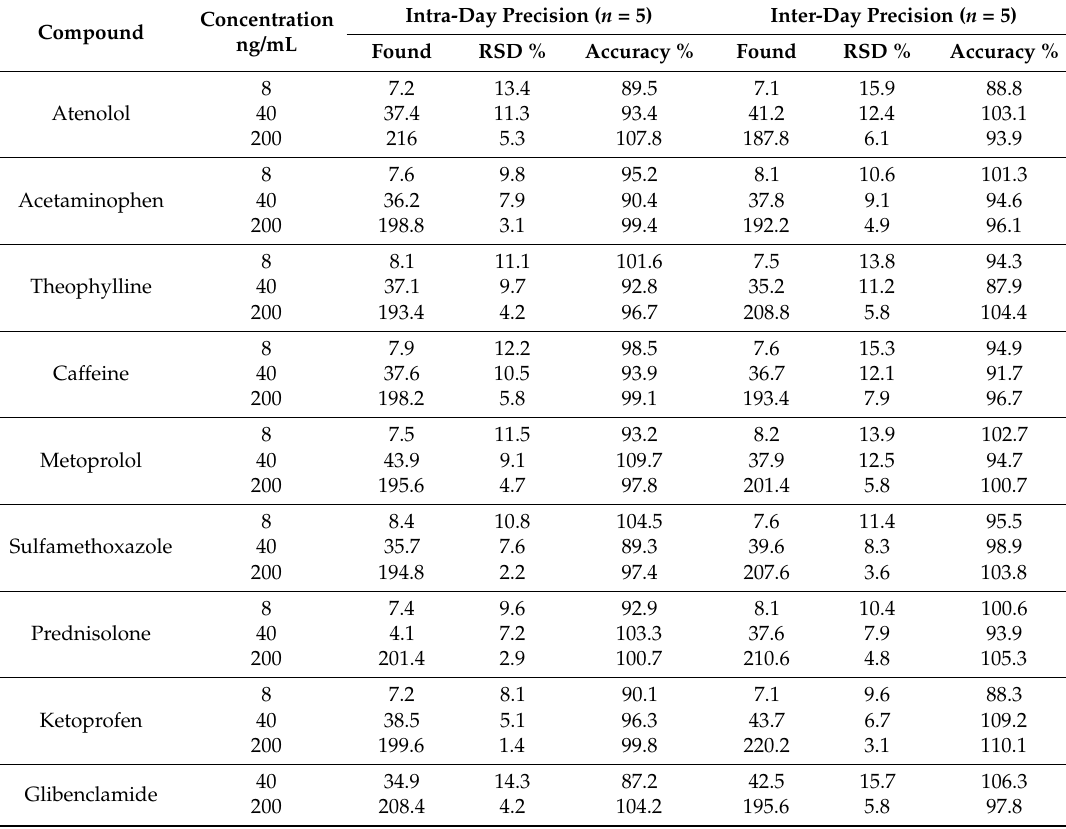
Table 4. Intra-day and inter-day precision and accuracy for all studied pharmaceuticals.